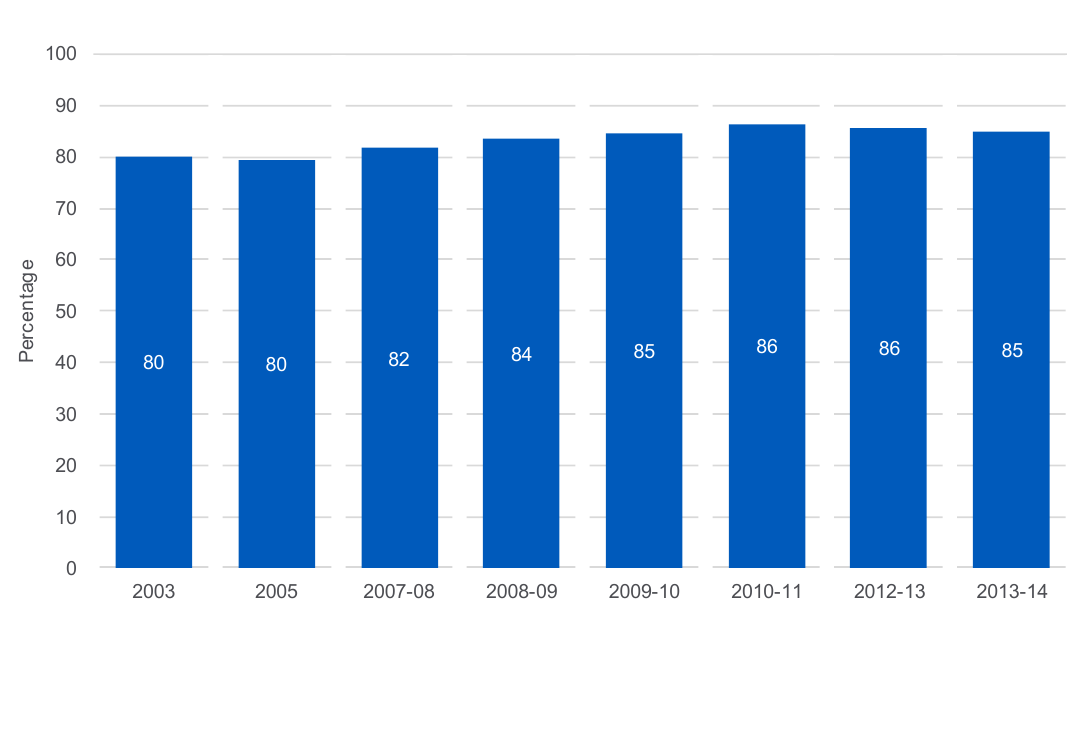
Figure 16: Proportion of people who agree that their local area is a place where people from different backgrounds get on well together, 2003 to